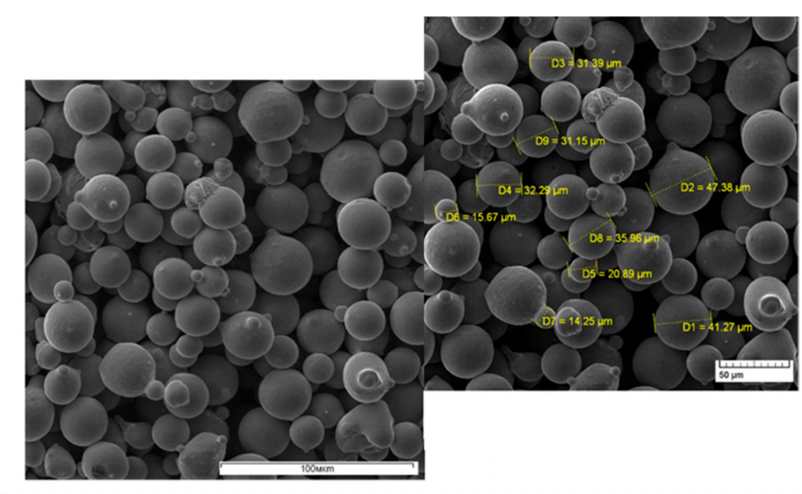
Figure 2. Particles of Ni-Cr-Al-Ti-based superalloy powder.